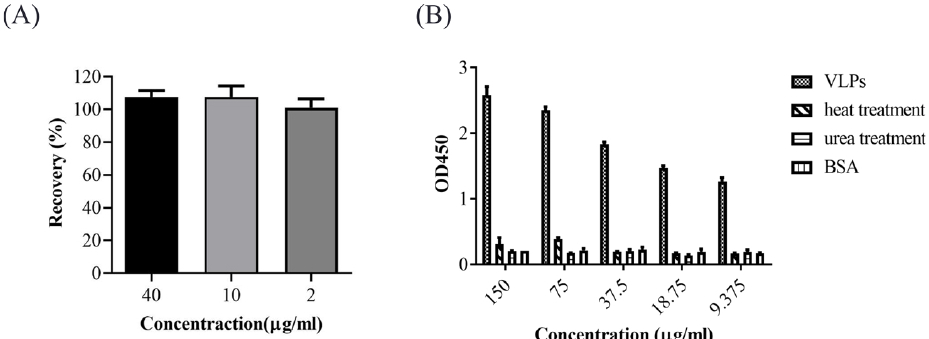
Figure 3. Characterization of the sandwich ELISA. ( A ) Three VLPs samples at concentrations of 40, 10, and 2 µ g/mL were analyzed with the sandwich ELISA, and the recovery values were calculated. Error bars represent standard deviation (N = 3). ( B ) Dilutions of PCV2 VLPs, heat, and denaturant urea-treated VLPs, and BSA protein at concentrations 150, 75, 37.5, 18.75, and 9.375 µ g/mL were analyzed with the sandwich ELISA. Error bars represent standard deviation (N =